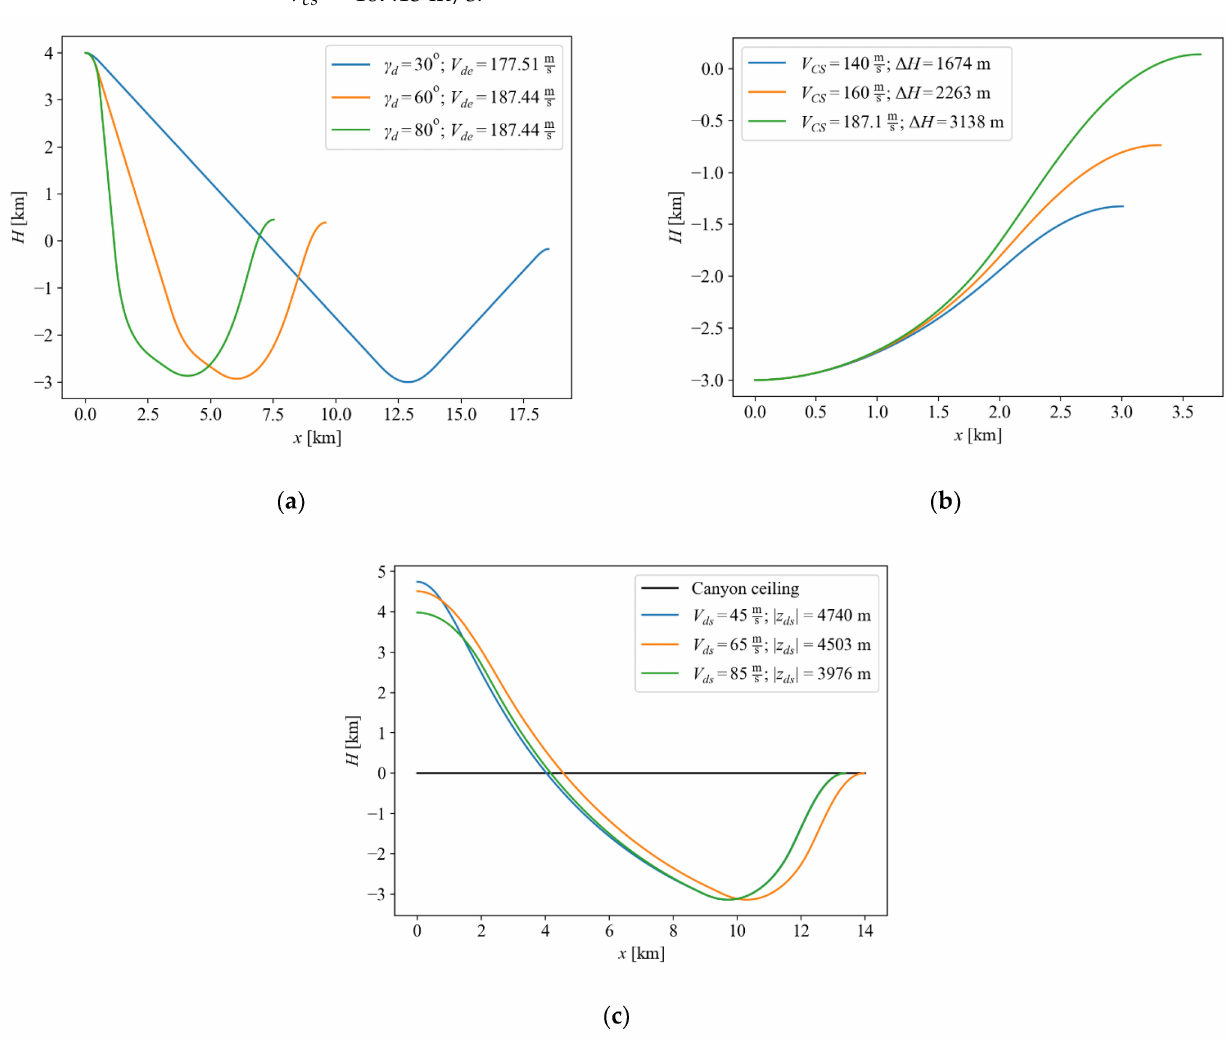
Figure 11. Sailplane trajectories for: ( a ) dive-pullout at three values of pitch angle, γ d ; ( b ) climb segment at three values of airspeed V cs ; ( c ) dive-pullout for three pairs of V ds and z ds at the beginning of a